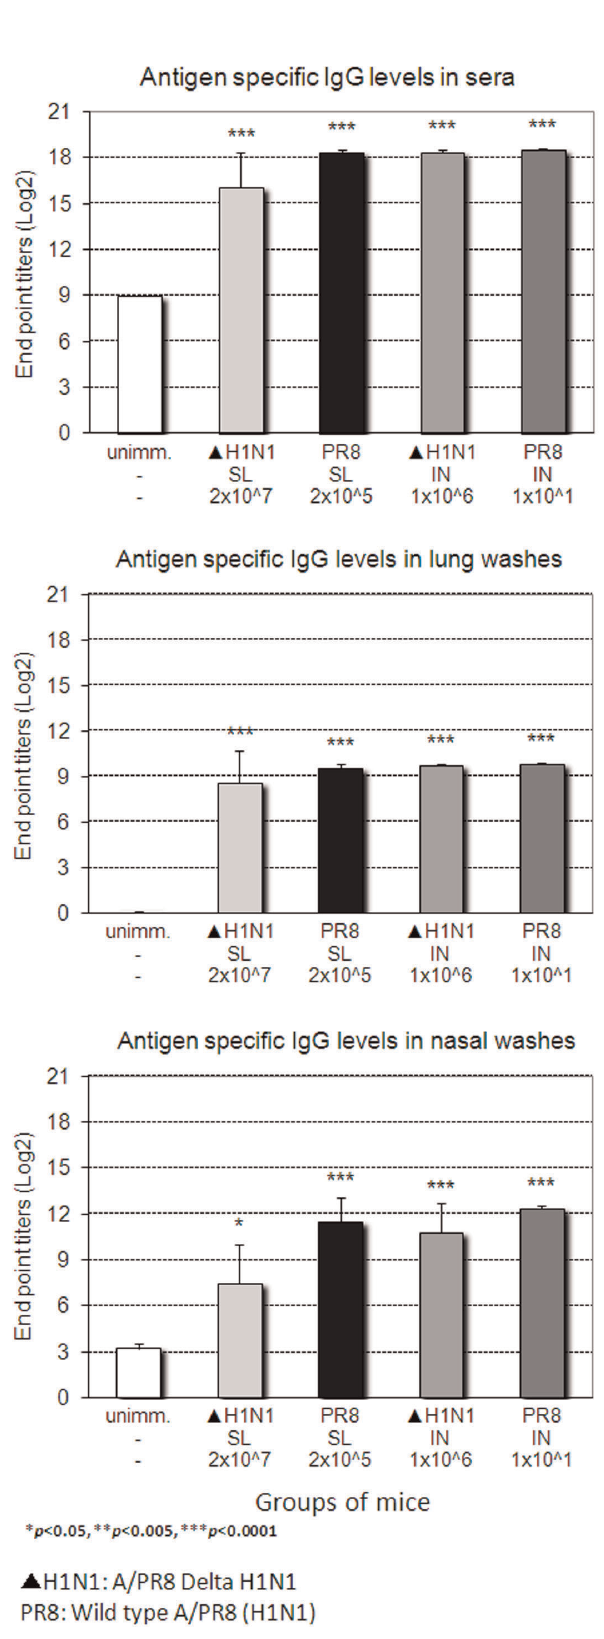
Figure 6. Levels of virus-specific IgG induced in mucosal and systemic compartments upon immunization with DeltaNS1 IAV. BALB/c mice were immunized with different doses of Delta